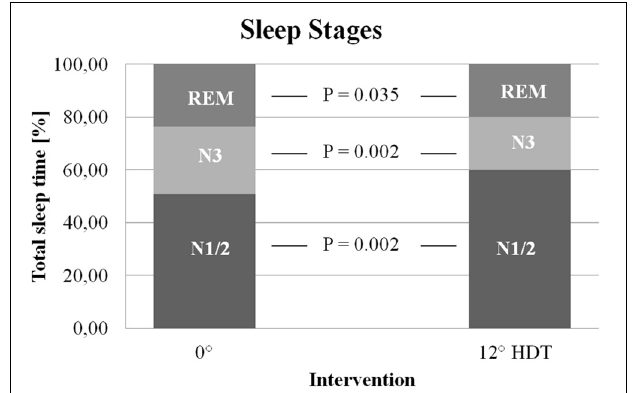
FIGURE 2 | Sleep stages. Percentage of slow wave sleep (20.2% ± 5.2% vs. 25. 4% ± 6.4%) and REM sleep (19.9% ± 5.7% vs. 23.7% ± 6.3%) were reduced during the − 12 ◦ HDT night. Percentage of light sleep increased (59.9% ± 7.2% vs. 50.9% ± 9.4%) when compared to horizontal position. HDT, Head down